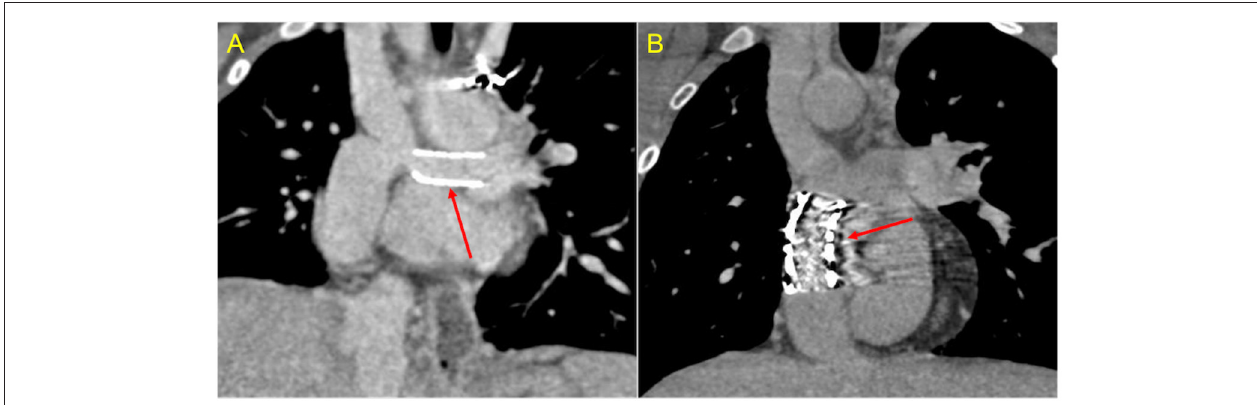
FIGURE 8 | Stent assessment with CCT. (A) Coronal image in a Fontan patient with left pulmonary artery stenting (red arrow) illustrates how stent lumen patency can be evaluated during the venous phase with a homogeneus opacification of all vessels. (B) Coronal image in a Fontan patient with IVC-to-pulmonary artery conduit stenting (red arrow) demonstrates that ruling out in-stent restenosis can sometimes be difficult due to beam-hardening artifacts.